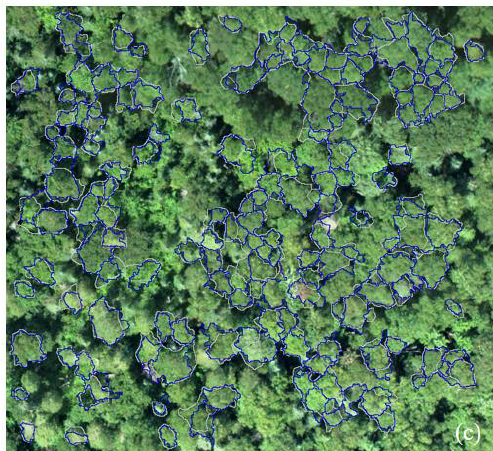
Figure 14. The correctly delineated crowns (in blue) obtained by the Crown Slices from Imagery (CSI) ( a ), the commonly used marker-controlled watershed segmentation (MWT) ( b ), and the proposed (SMS) ( c ) methods, respectively, and the corresponding references (in white) of the deciduous forest plot.